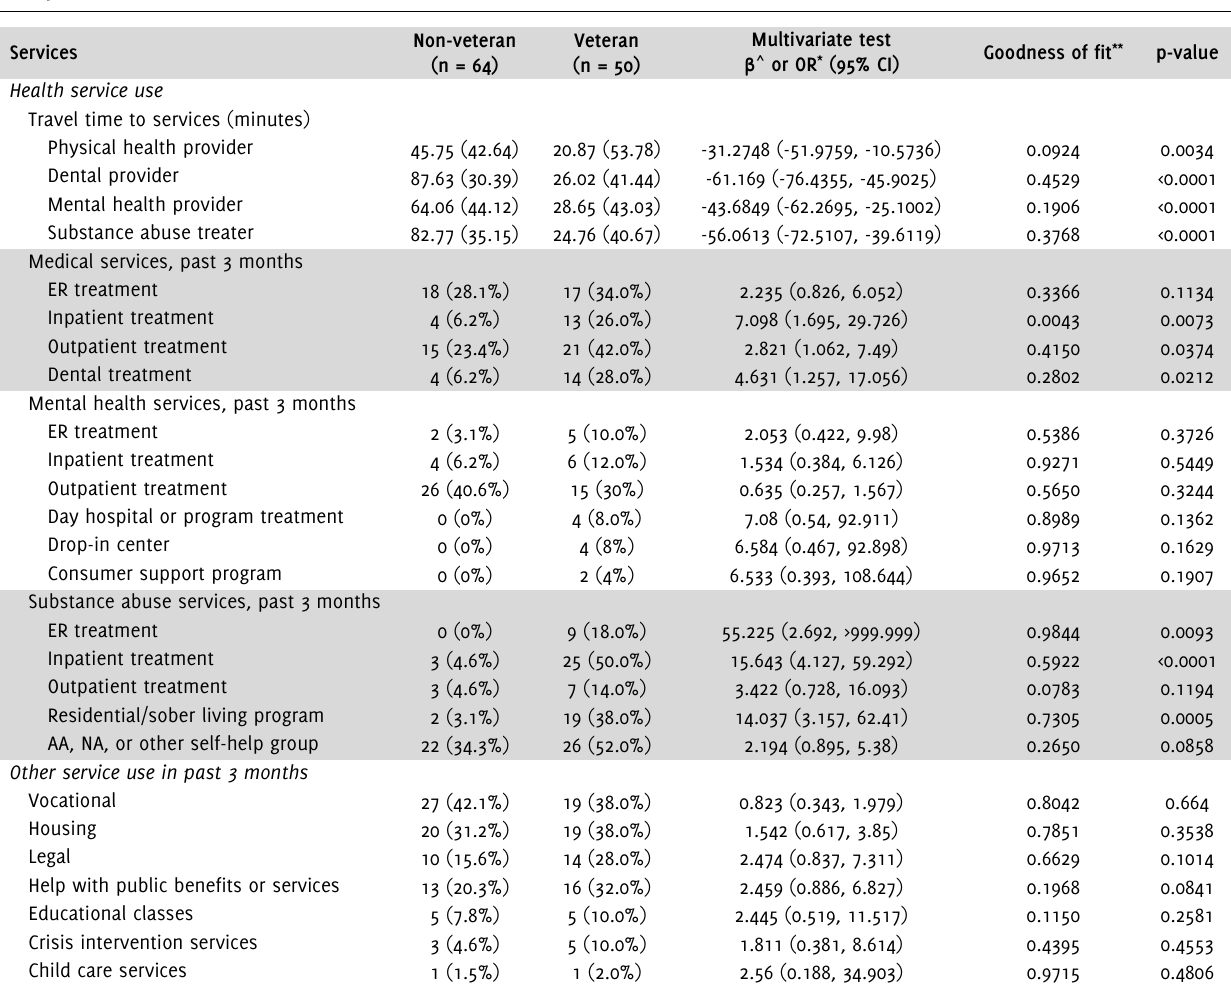
Table 3 . Health Care and Other Service Use of Rural Homeless Veterans and